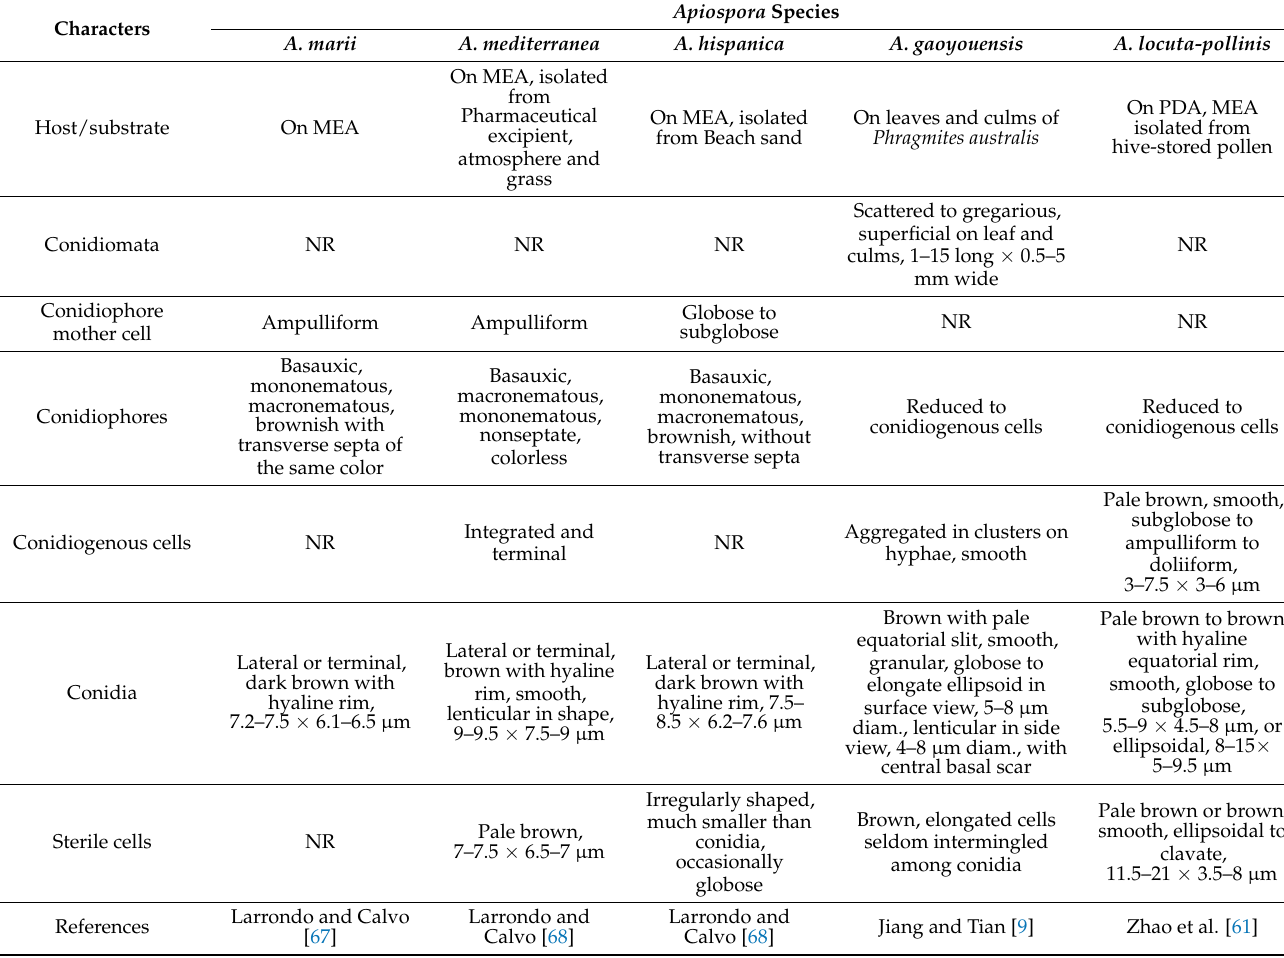
Table 3. Morphological comparison among Apiospora species in the A. locuta-pollinis / marii